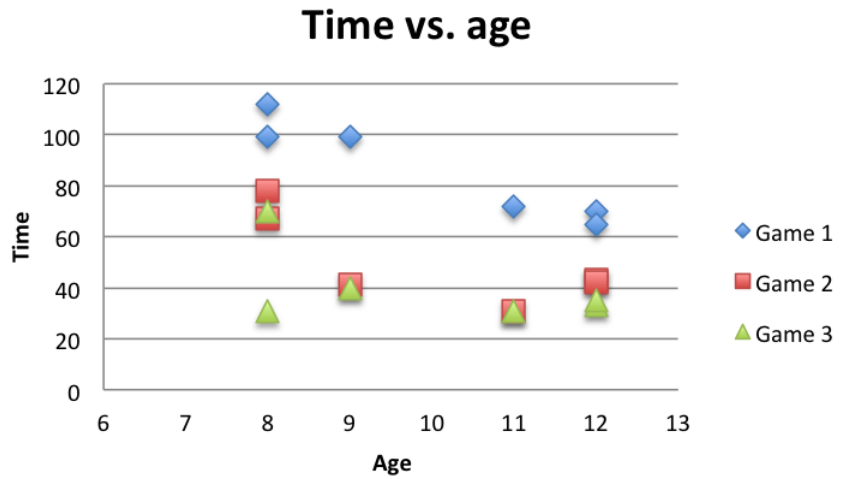
Figure 10. Graph representing the time with respect to age of